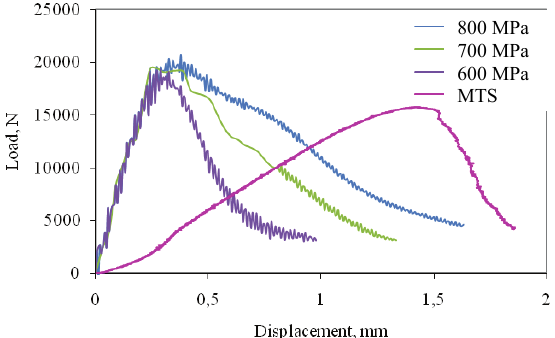
Figure 11: The load-displacement values at the different maximum strength of the cohesive element and the comparison with the experimental data.